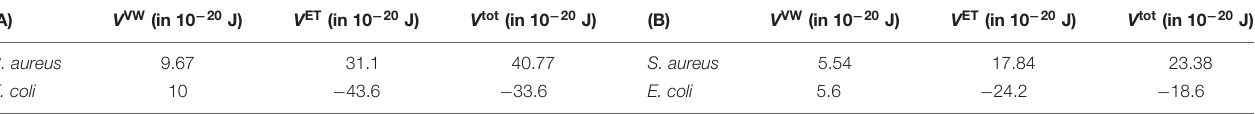
TABLE 3 | Interaction energies for a separation distance d = 0.1 nm between GO 2D NSs and S. aureus and E. coli bacteria, calculated by the DLVO